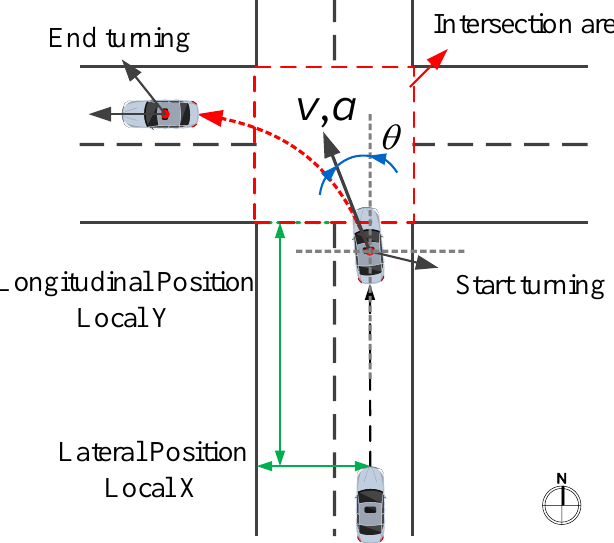
Figure 6. The process of a vehicle entering the intersection.